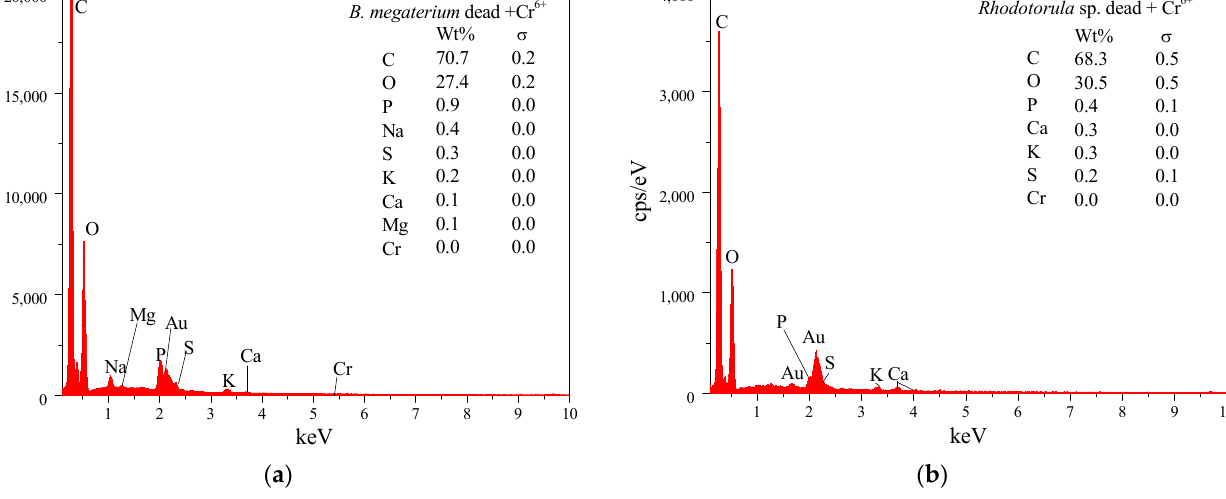
Figure 13. Elemental composition of biosorbents: ( a ) Bacillus megaterium and ( b ) Rhodotorula sp. after Cr 6+ ions biosorption. Cr 6+ ions